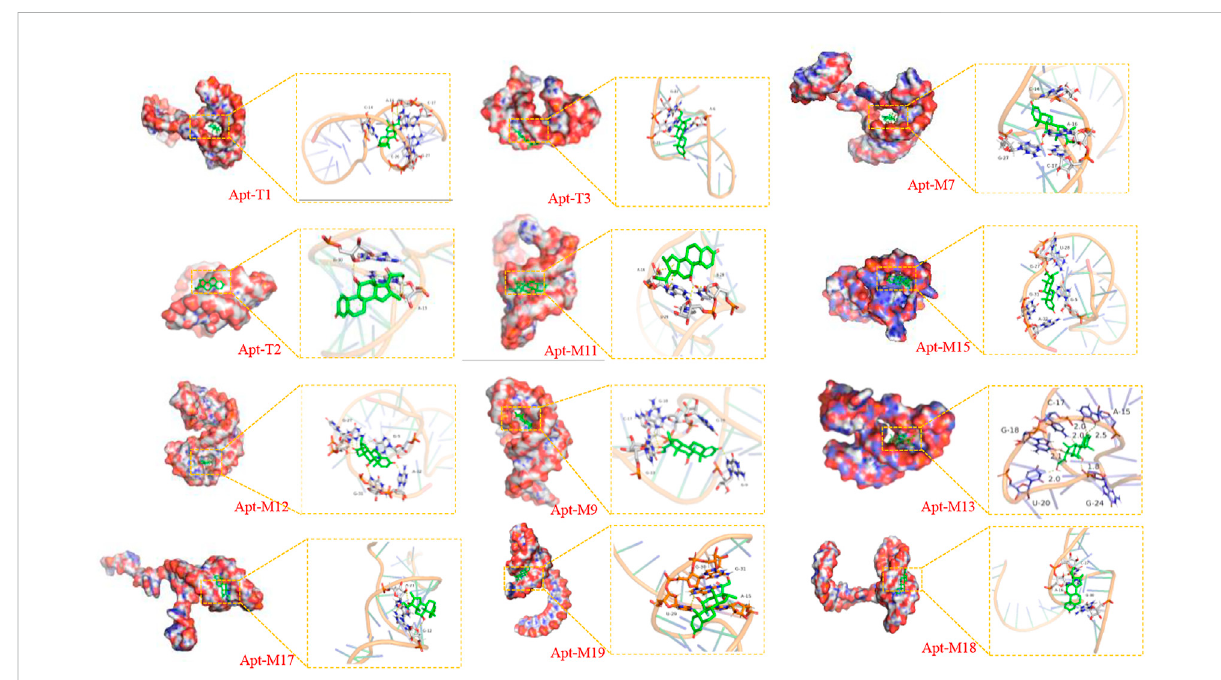
FIGURE 2 Visualization of molecular dynamics simulations of truncated aptamers and mutated aptamers with